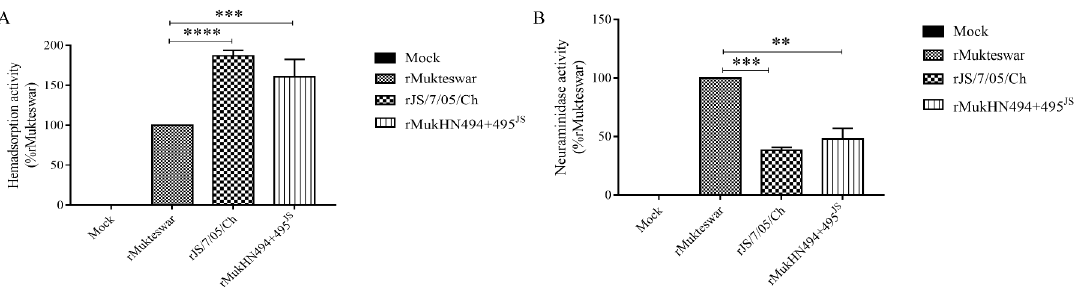
Figure 4. HAd and NA activities of NDVs bearing different HN proteins. Vero cells were infected with three viruses at 0.1 MOI for 24 h, and then detected for the HAd activity ( A ) and the NA activity ( B ), respectively. HAd and NA activities of NDV are normalized to the expression of the values for rMukteswar, which was set at 100%. ** p < 0.01, *** p < 0.001, and **** p < 0.0001.